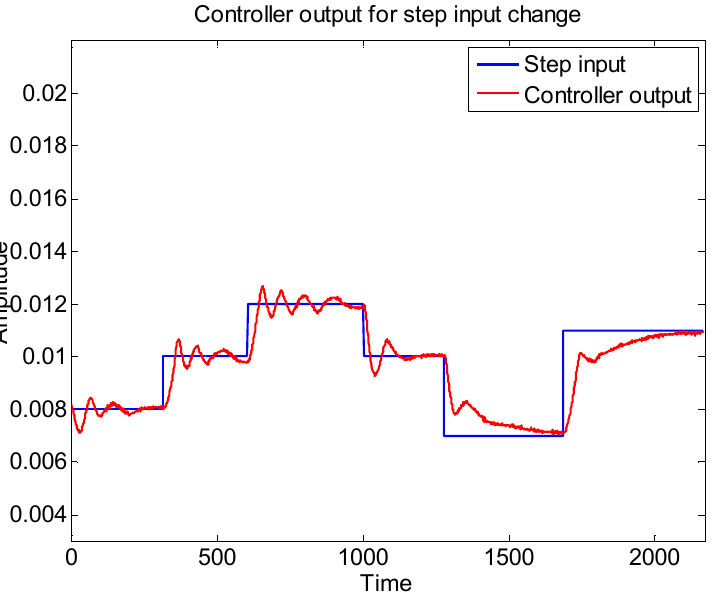
Figure 13. Controller response.